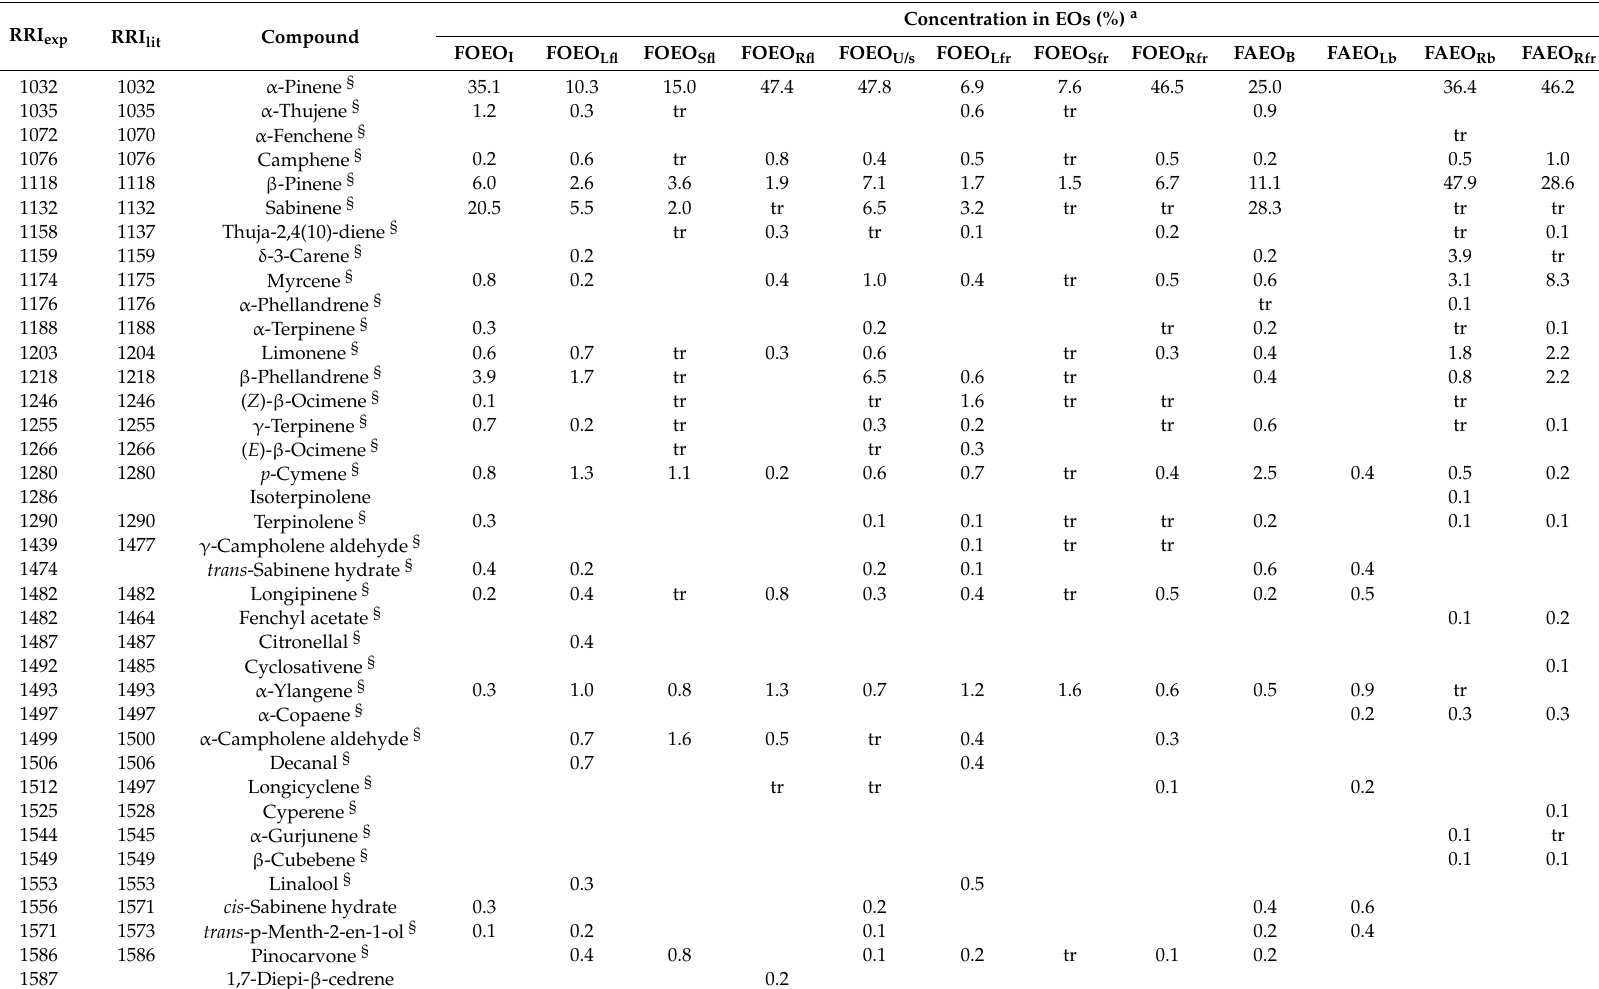
Table 1. Composition of the volatile compounds identified in the essential oils from different parts of F. ovina and F. akitschkensis